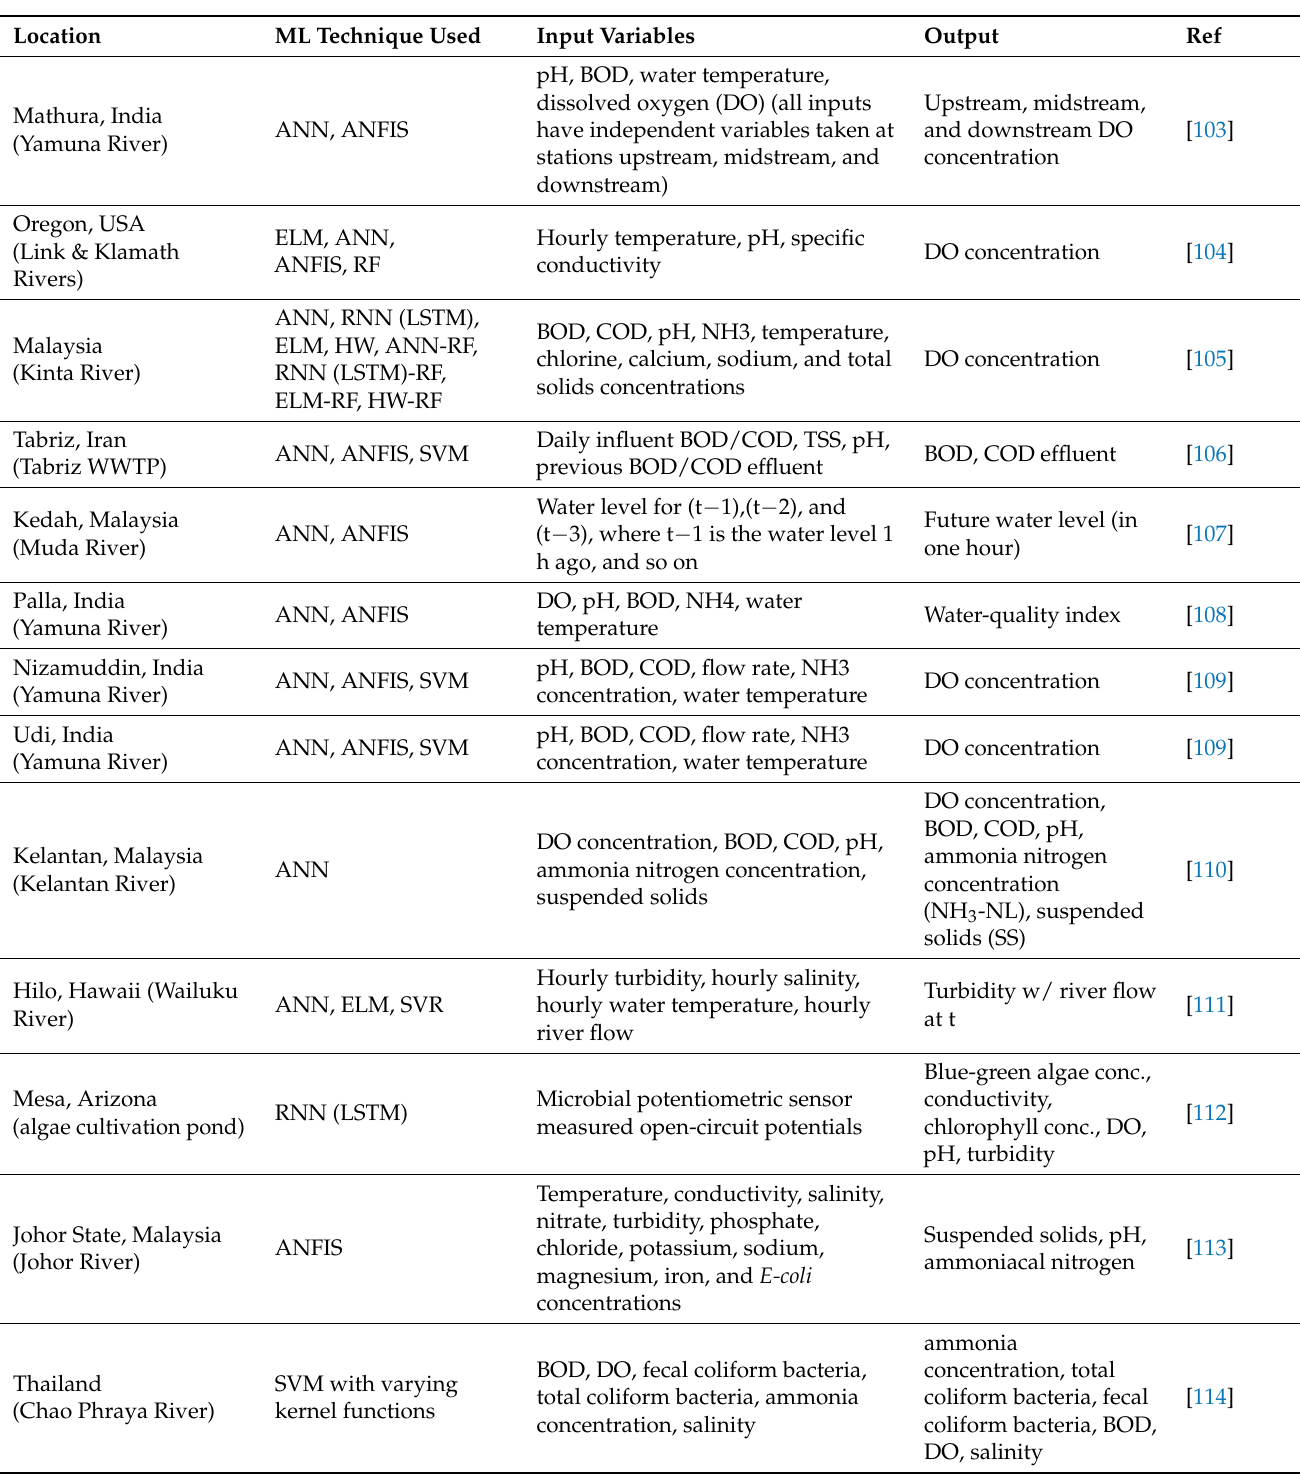
Table 5. ML to model and predict water-quality parameters and environmental